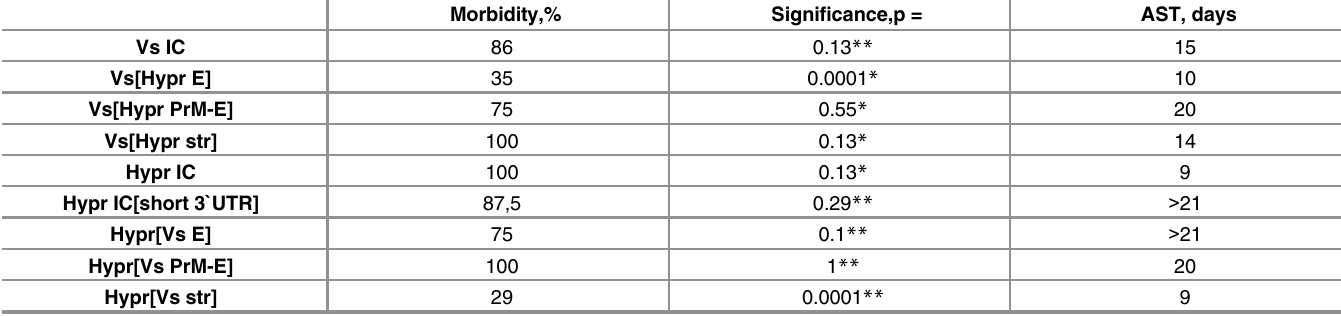
* — signi fi cance of the differences in comparison to wild-type VsIC virus was determined by single sample Student ’ s t-test for proportions ** — signi fi cance of the differences in comparison to wild-type HyprIC virus was determined by single sample Student ’ s t-test for